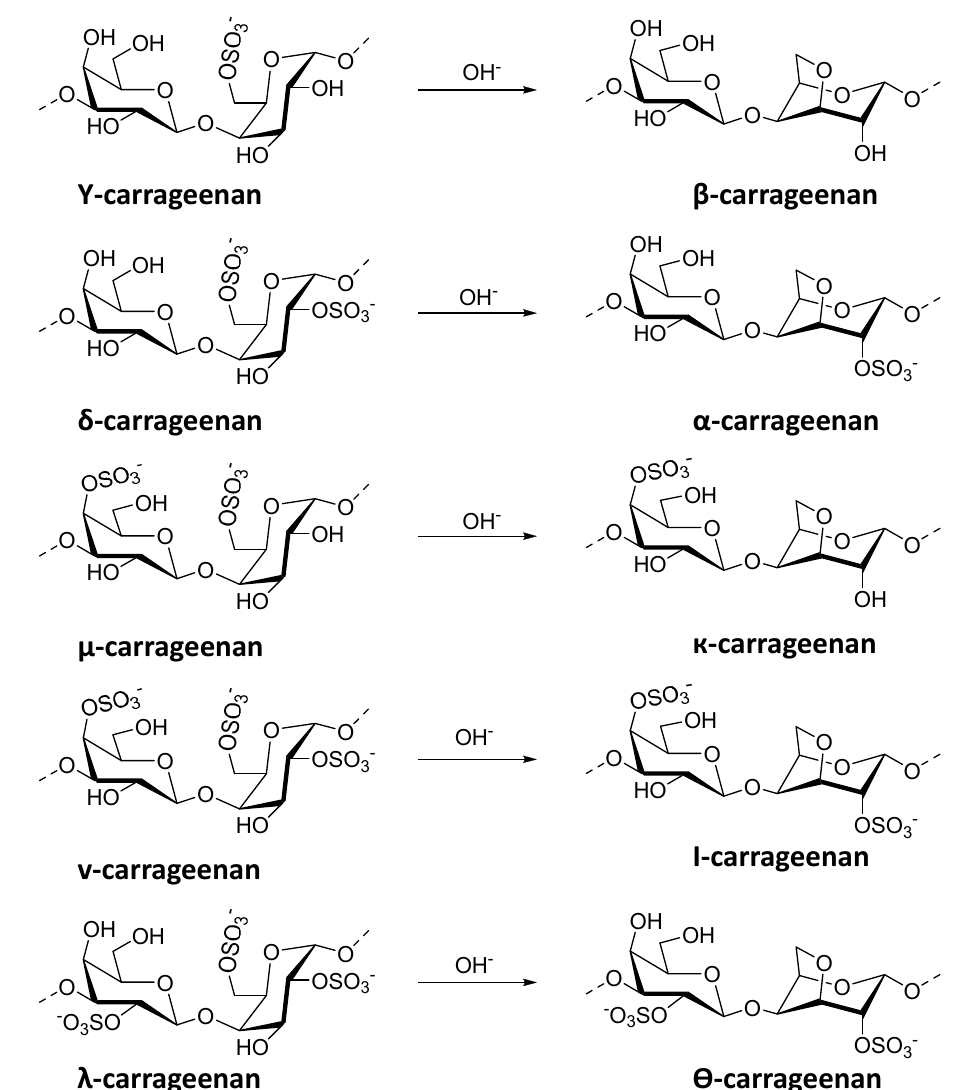
Figure 6. Main structures of carrageenans and derived carrageenans after alkaline hydrolysis.